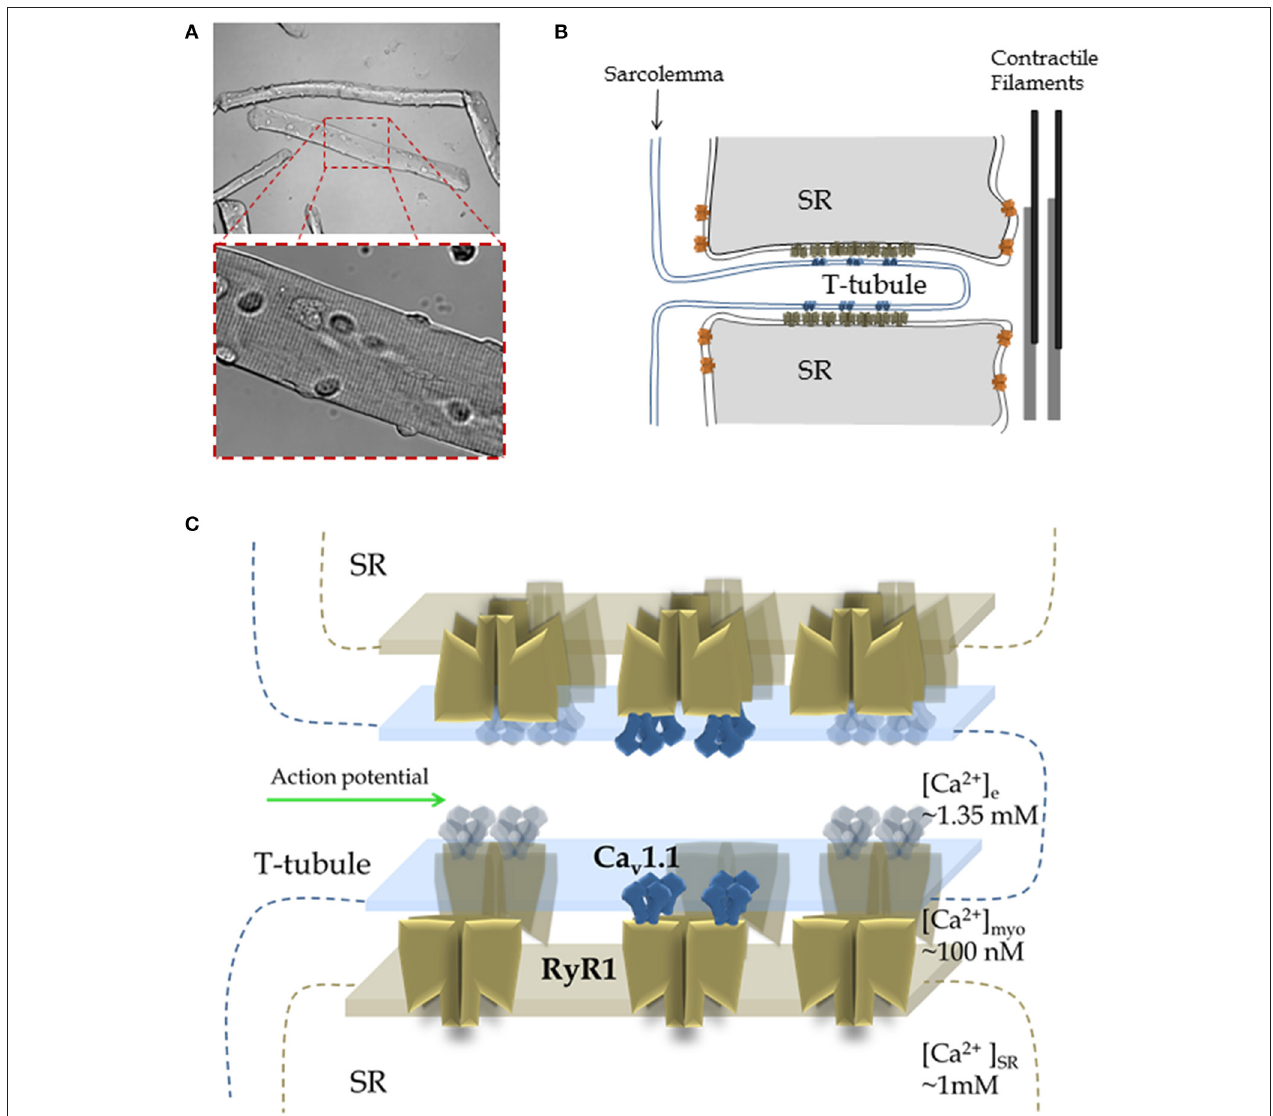
FIGURE 1 | Muscle structure and function: from the myofiber to RyR1 Ca 2 + release complex. (A) Morphology of skeletal muscle fibers. Top Panel: Transmitted light image of isolated muscle fibers from mouse flexor digitorum brevis via enzymatic dissociation; image was acquired using low magnification. Lower Panel: A higher magnification image of the fiber segment enclosed by a dashed rectangle. Note the characteristic striated pattern of muscle fibers, which results from highly organized array between sarcolemma, sarcoplasmic reticulum (SR), contractile elements and cytoarchitecture of the fibers. (B) Structure of the triad. In most cases the myoplasmic side of the junctional SR is closely apposed either to T-tubule or surface membrane, forming different junctions called dyads, triads, or peripheral coupling. The cartoon depicts a longitudinal section of the T-tubule axis, but a cross-section of the triad, a specialized array formed by the T-tubule and two segments of the terminal junctional SR (aka the terminal cisternae). The T-tubules are invaginations of the sarcolemma that propagate the action potential and possess the Ca v 1.1 voltage sensors that initiate the early steps of ECC. The voltage dependent Ca 2 + channels, Cav1.1 (blue, aka DHPR), are positioned in both the T-tubule and sarcolemma. The SR Ca 2 + release channel, RyR1 (brown), is located on the junctional domain of the SR surface, facing the T-tubules, and is also known as the junctional SR face membrane. Some RyRs may be present in adjacent parajunctional SR domains (orange). (C) Detailed architecture of the Cav1.1-RyR1 complex shown in (B) . About half of the total RyR1s do not associate with Cav1.1, resulting in an alternating pattern of “free” and Cav1.1-associated RyR1s. Note: In addition to Cav1.1 and RyR1, many other proteins form part of the T-tubule- junctional SR complex (e.g., FKPB12, triadin, junctin, Casq1) and are not shown here. Panels (B,C) are based on references: (Franzini-Armstrong and Porter, 1964; Franzini-Armstrong and Nunzi, 1983; Block et al., 1988; Franzini-Armstrong and Jorgensen, 1994; Franzini-Armstrong and Kish, 1995; Franzini-Armstrong and Protasi, 1997).